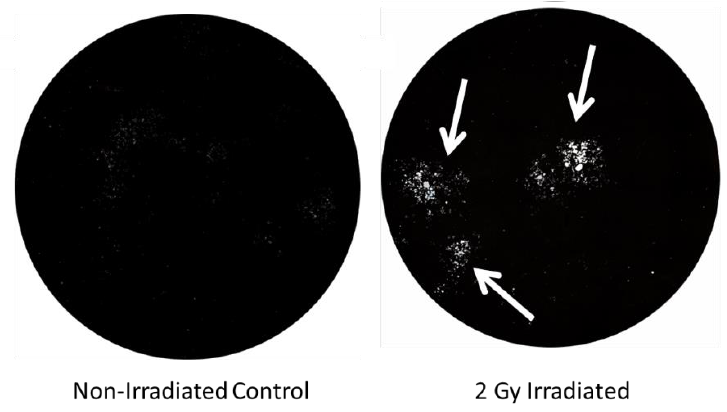
Figure 1. 2 Gy increases osteoclast activity, resulting in a 390% increase ( p < 0.05) in resorbed surface area of hydroxyapatite (white spots indicated by arrows). n = 3 replicates.